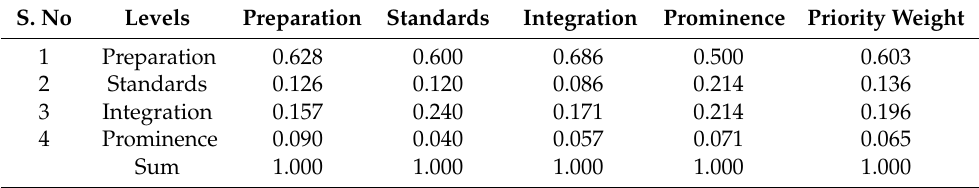
Table 25. Normalized matrix between level wise success factors. S. No